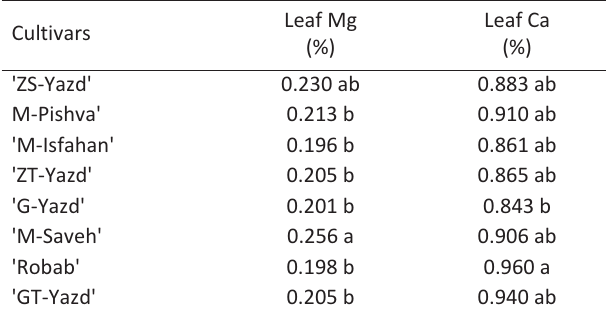
Table 6 ­ The comparison of root mineral elements in eight pomegranate